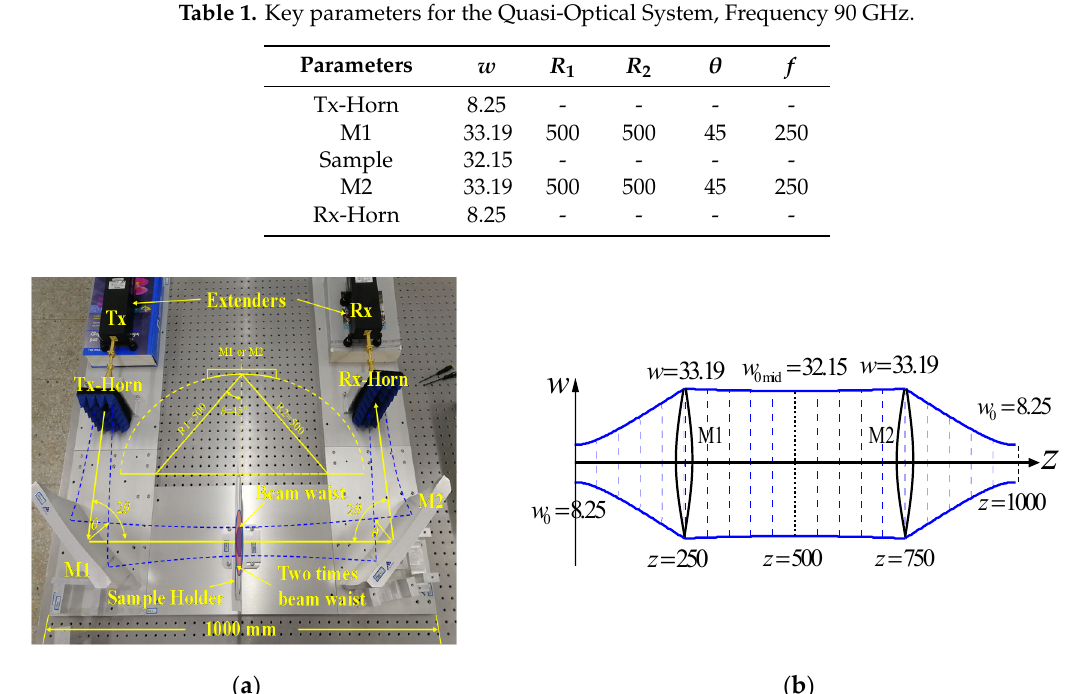
(dashed curves) are plotted in Figure 3b. The beam radius at the location of M1/M2 is 33.19 mm,